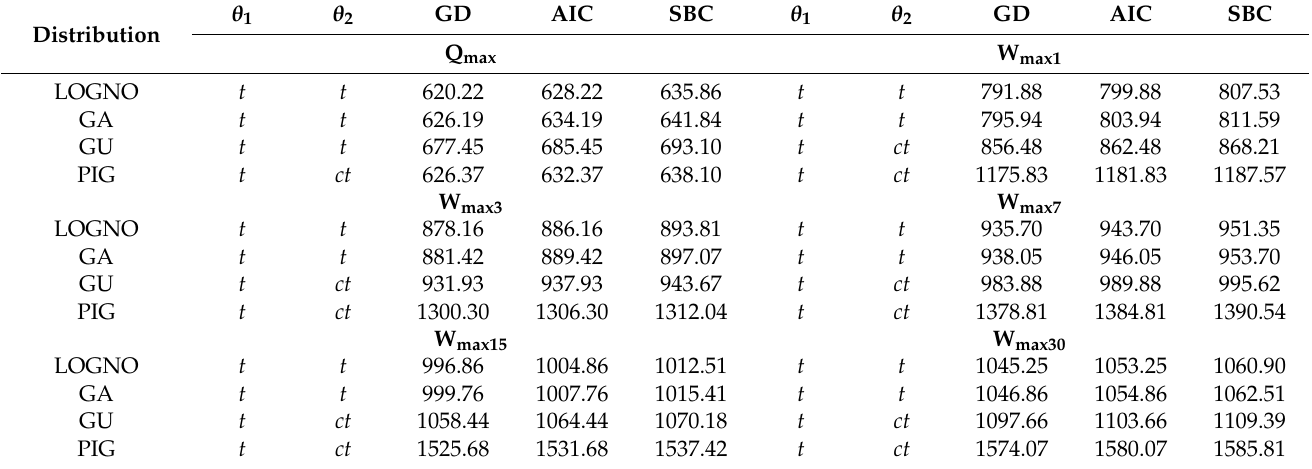
Table 5. Summary for the fitted models type 1 and the type of dependence between time and the distribution parameters: t means linear dependence; ct refers to a parameter that is constant. Global fit deviation (GD) denotes the evaluation value of the GD. AIC denotes the evaluation value of the AIC criterion. Schwarz Bayesian criterion (SBC) denotes the evaluation value of the SBC criterion. Lower AIC and SBC represent a better